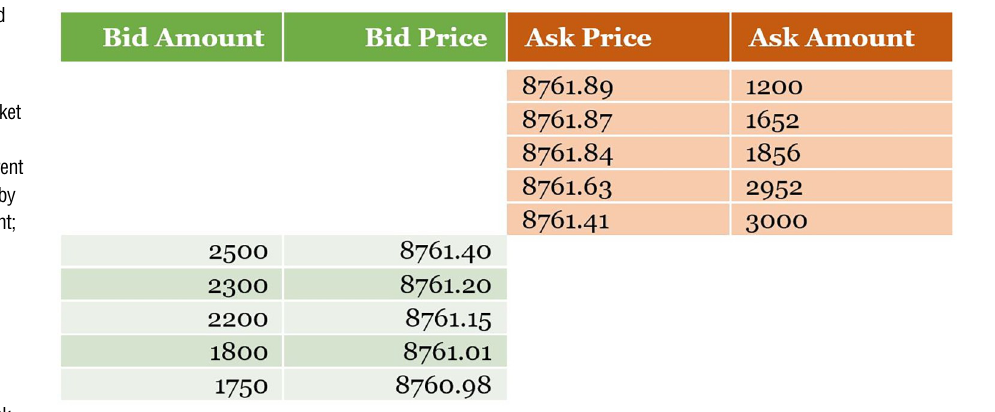
Fig 1. Orderbook snapshot for